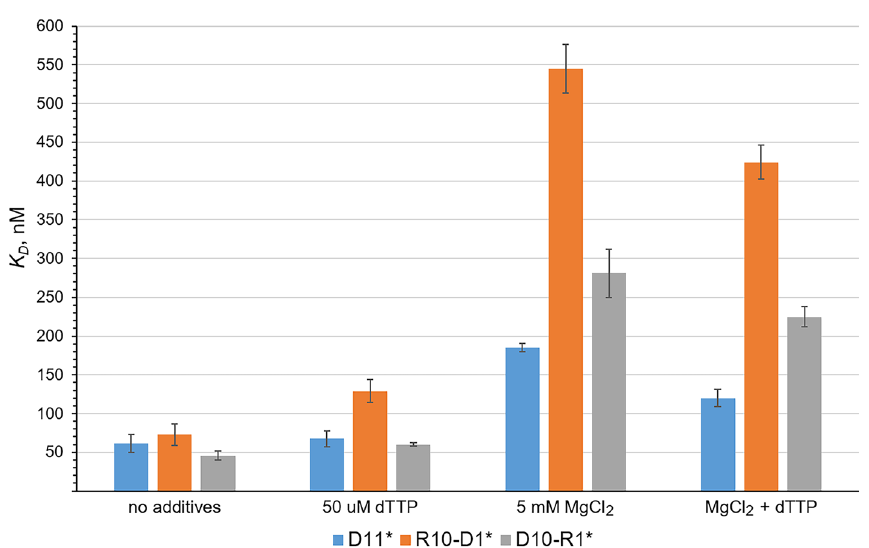
Figure 3. Effect of dTTP and Mg 2+ on hPolε CD affinity to a template:primer. The data are presented as bar graphs showing the mean ± SD (n = 3). The primer type is indicated below the additives. Asterisk indicates the absence of primer 3 ′